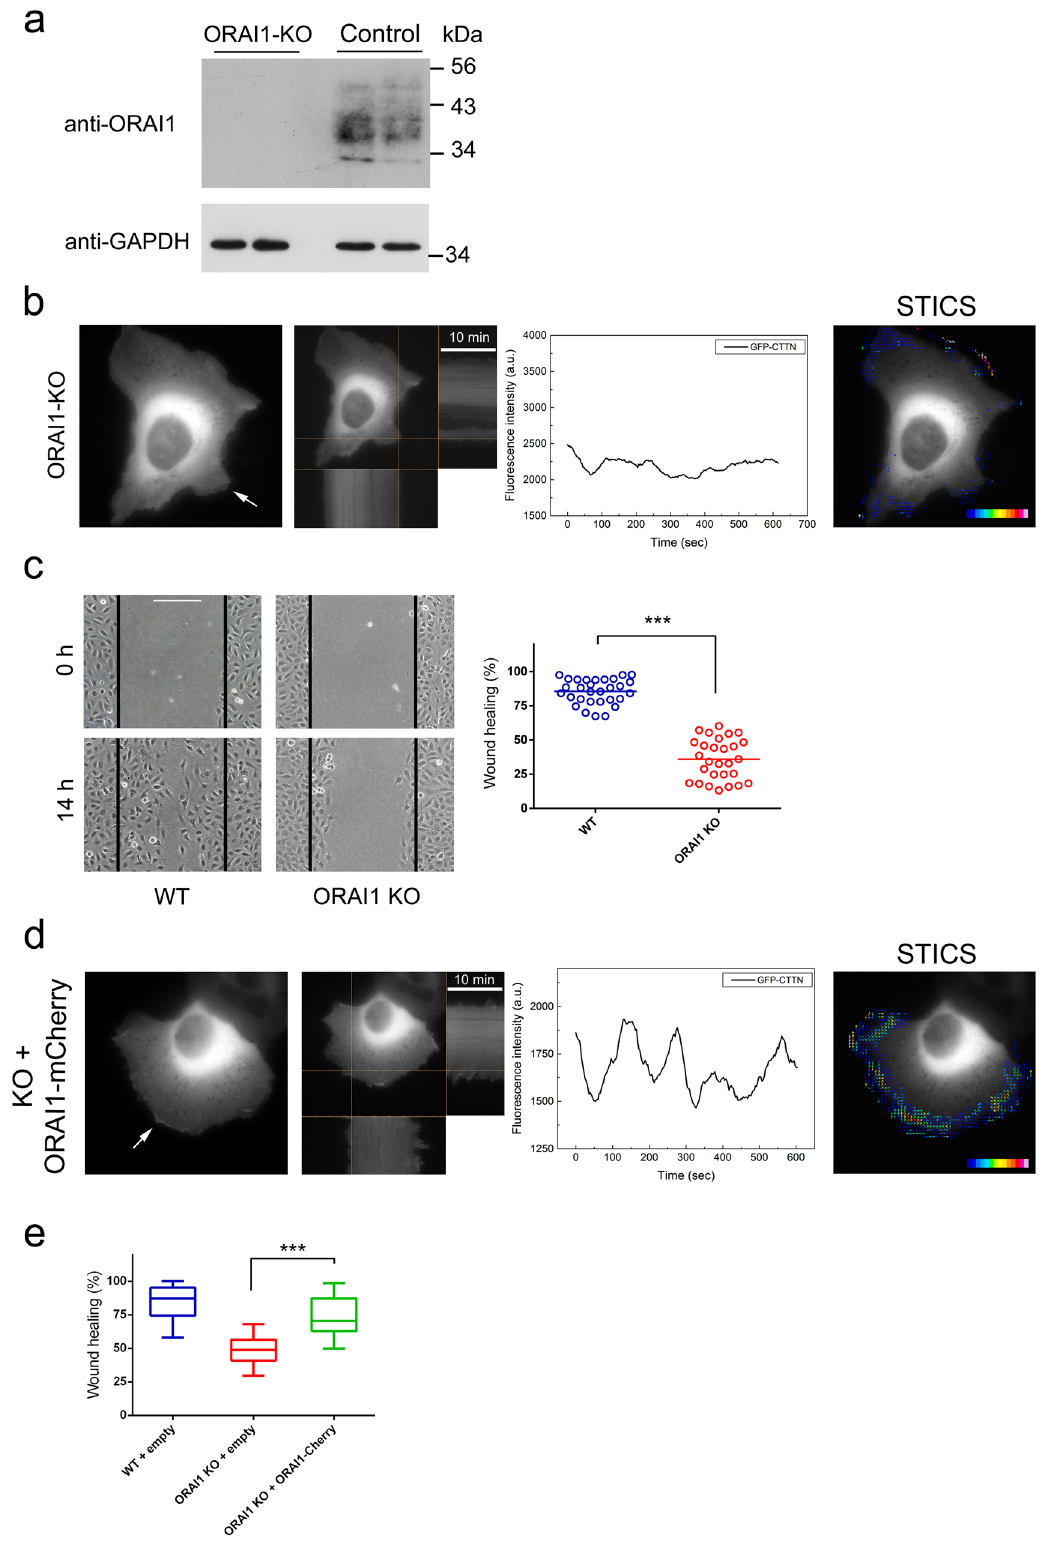
Figure 6. Knock-out of ORAI1 expression by CRISPR/Cas9 D10A gene editing. Gene editing was performed in the U2OS cell line following the strategy shown in Supplementary Fig. 2. ( a ) The selected clone of cells was assessed for ORA1 expression by immunoblot. GAPDH was used as loading control. ( b ) Panel 1: ORAI1-KO cells were transfected for the transient expression of GFP-CTTN, and monitored for 10 min at 37 °C (image acquisition every 3 sec). Assay medium was Leibovitz’s L-15 medium + 10% FBS. Panel 2: Orthogonal projections show the kymograph of the fluorescence intensity over the time of assay (10 min). Panel 3: GFP-CTTN fluorescence of the selected area is shown to indicate the frequency and extent of membrane ruffling. Panel 4: STICS analysis is